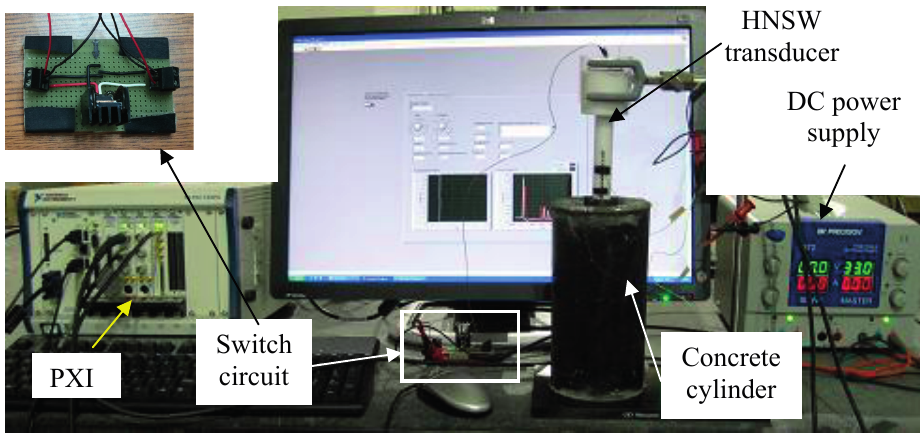
Figure 4. Photo of the experimental setup. Top left: close-up view of the switch